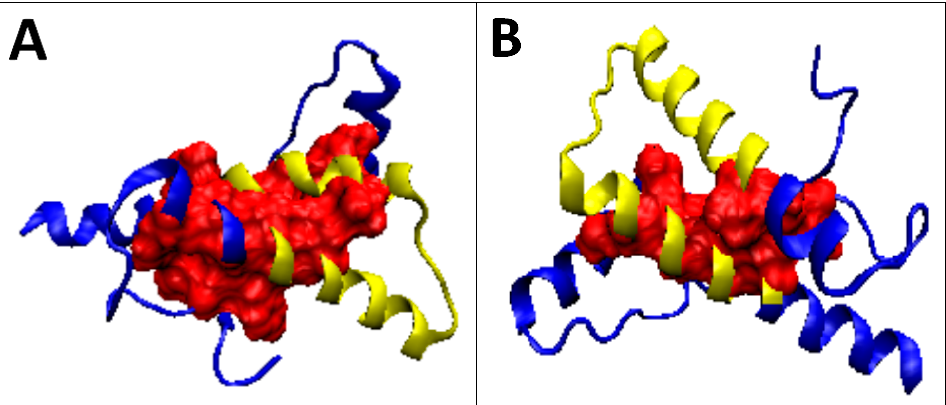
Figure 5. 3D presentation of the selected prion proteins: ( A ) 1JN; ( B ) 1DX0. Hydrophobic core marked in red, fragment limited by Cys participating in SS-bond marked in yellow. limited by Cys participating in SS-bond marked in yellow.